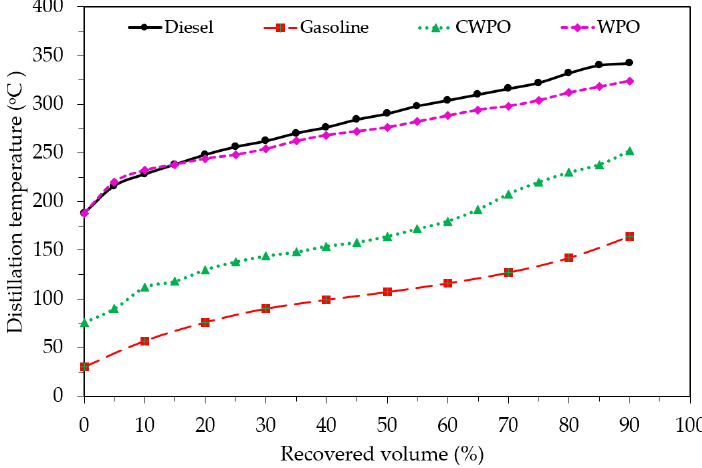
Figure 2. Distillation curves of test fuels obtained by fractional